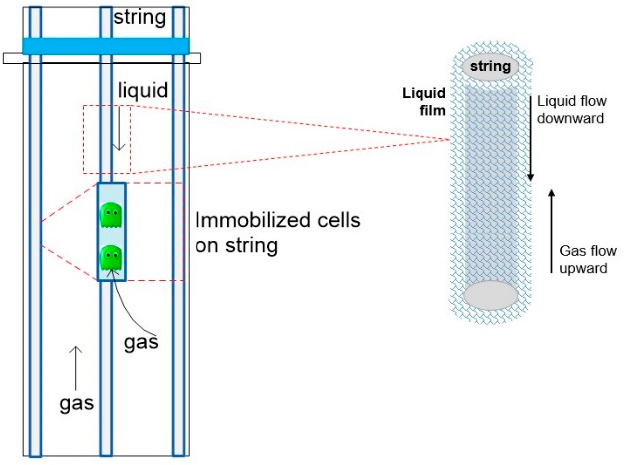
Figure 1. The concept of the string film reactor (SFR).